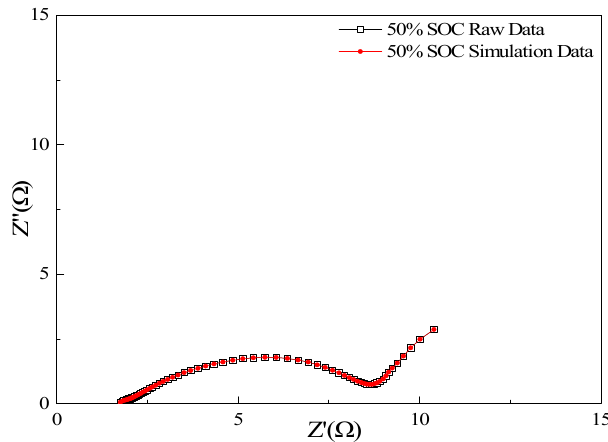
Figure 9. Comparison between testing data and fitting result.